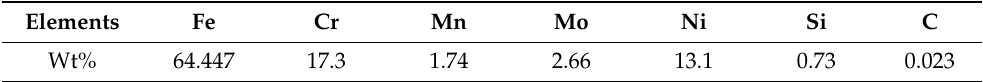
Table 1. Chemical Compositions of 316 L stainless steel.